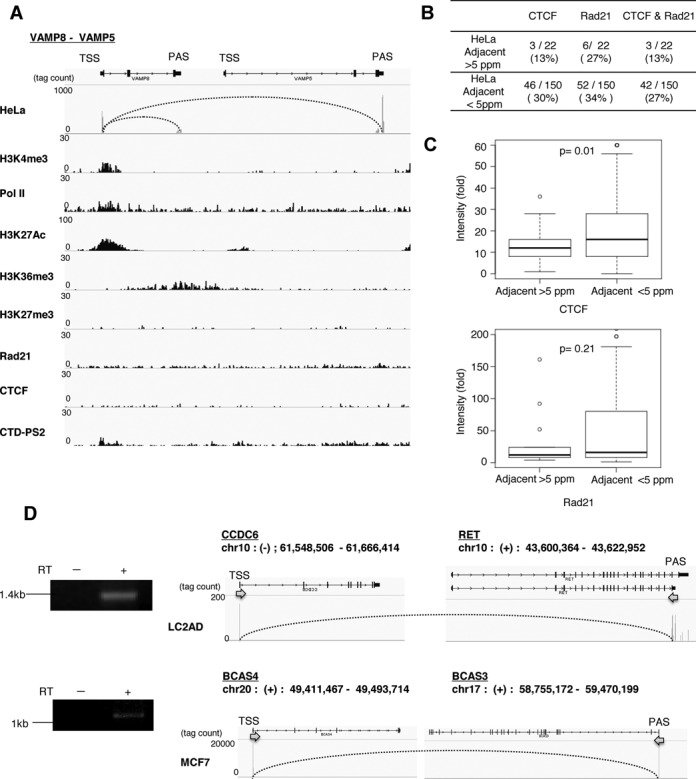
Use of the TSS/PAS library to analyze diverse transcript regions. (A) Examples of genomic regions for which the TSC-PAC pairs ‘connected’ adjacent RefSeq genes. Patterns of TSS-PAS tags (from the HeLa dT library) and ChIP Seq patterns are shown. Antibodies used for ChIP Seq are shown in the left margin. For ChIP Seq tracks, a unified scale was used for the y-axis. (B) Frequencies of ChIP Seq peaks (P < 1e−5 as of MACS) for Rad21 and CTCF among the ‘connected’ RefSeq genes. Cases where ChIP Seq peaks were identified in the regions between the corresponding RefSeq regions were counted among the total cases of ‘connected’ RefSeq genes. Populations were counted separately for cases having TSC-PAC pairs of >5 ppm (upper) and <5 ppm (lower) in HeLa cells. (C) Boxplot of the densities of the ChIP Seq signals (fold of normalized tag counts divided by normalized background input) for the indicated populations [‘connected’ genes having TSC-PACs of >5 ppm (left) and <5 ppm (right)]. The antibody used for the ChIP Seq analysis is shown at the bottom. The statistical significance of the difference, as evaluated by Wilcoxon's signed rank test, is shown at the top. (D) Fusion gene transcripts in cancerous cells identified in this study. Graphical views are shown for the cases of the BCAS4-BCAS3 gene in MCF7 cells (top) and the CCDC6-RET gene in LC2AD cells (bottom). RT-PCR validations of the identified fusion gene transcripts are shown in the left margin.